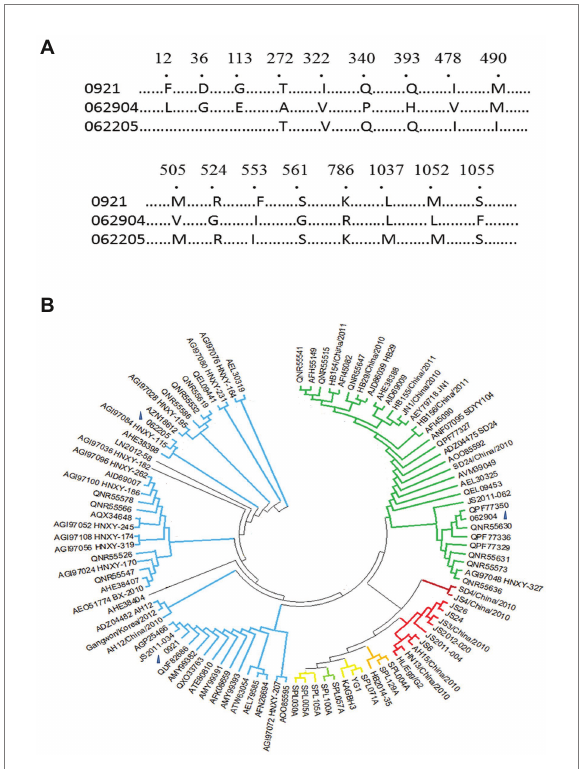
FIGURE 2 Clades and phylogenetic tree of M segments of three novel isolates. (A) M segments of isolates (0921, 062205, and 062904), Number showed the different amino acids among of them (1,073 amino acids of M segment). (B) The M phylogenetic tree of the three isolates with 99 different isolates was aligned using Mega 11 (Mega 6.0 software updated version). According to the M phylogenetic tree, 0921 and 062205 belonged to the C2 clade. 062904 belonged to the C3 clade. Clades C1-C4 and J are represented with different colors: Green-C3 clade, Crimson-C1 clade, Red-C4 clade, Blue-C2 clade, Yellow-J clade. The blue triangle marked the loci of 0921, 062904, and 062205 on the phylogenetic